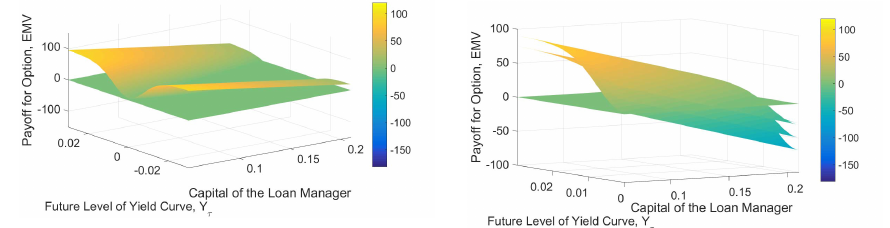
Figure 7. Payoff for the Embedded Option